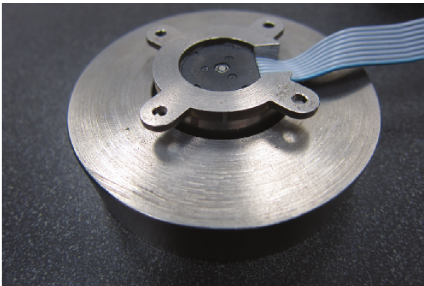
Figure 5: Reaction wheel assembly.